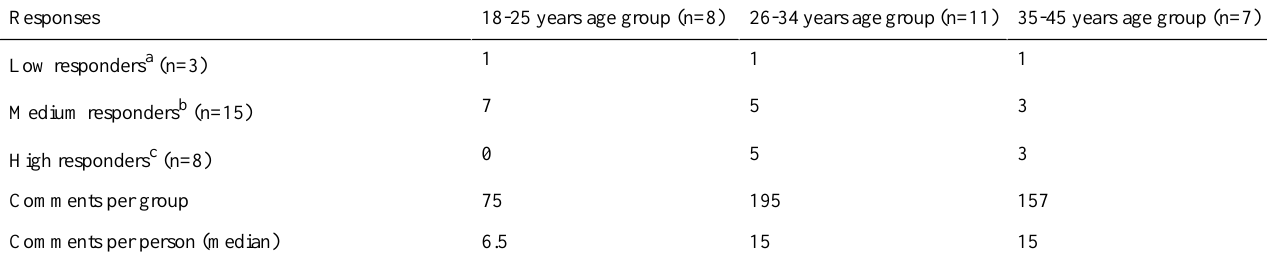
Table 2. Interaction among the women of reproductive age in online focus groups categorized by age and type of